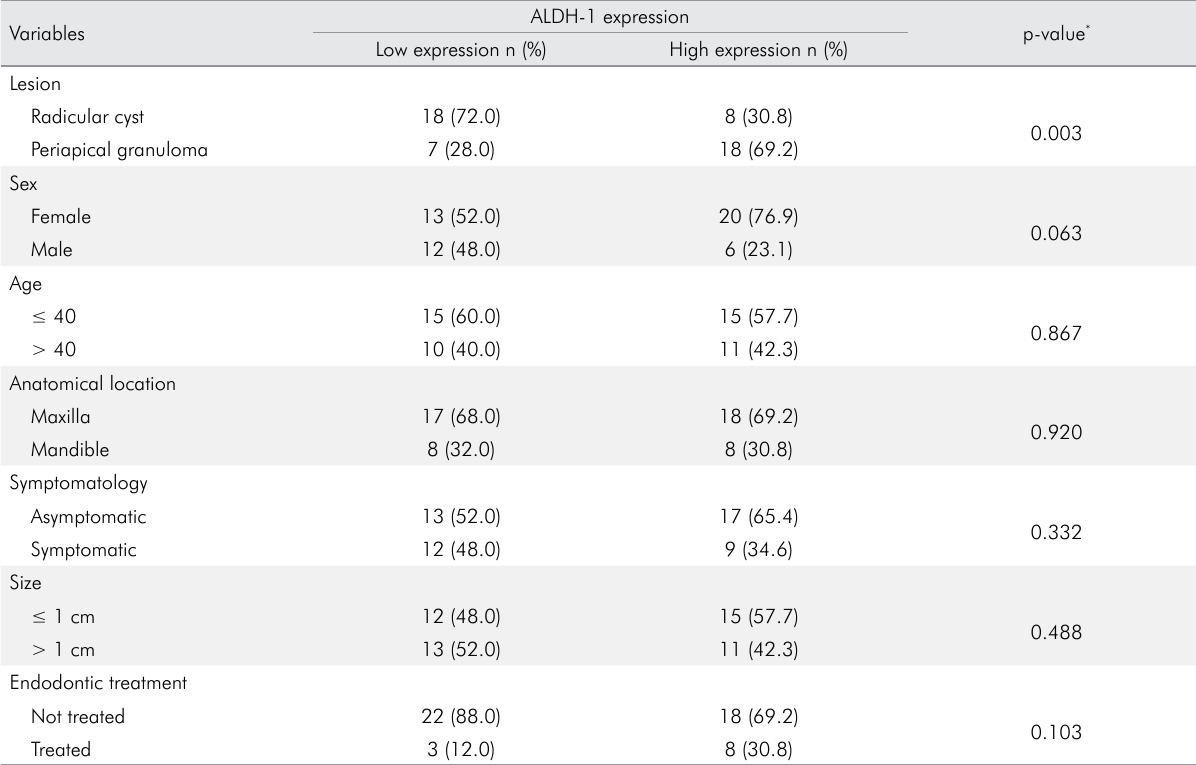
Table 2. Association of ALDH-1 protein expression and clinicopathological data of cases of periapical granulomas and radicular cysts. Variables